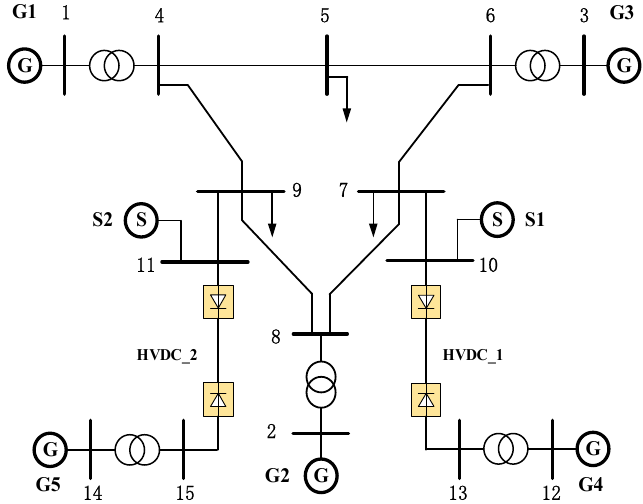
Figure 9. The topology of modified IEEE-9 test system.